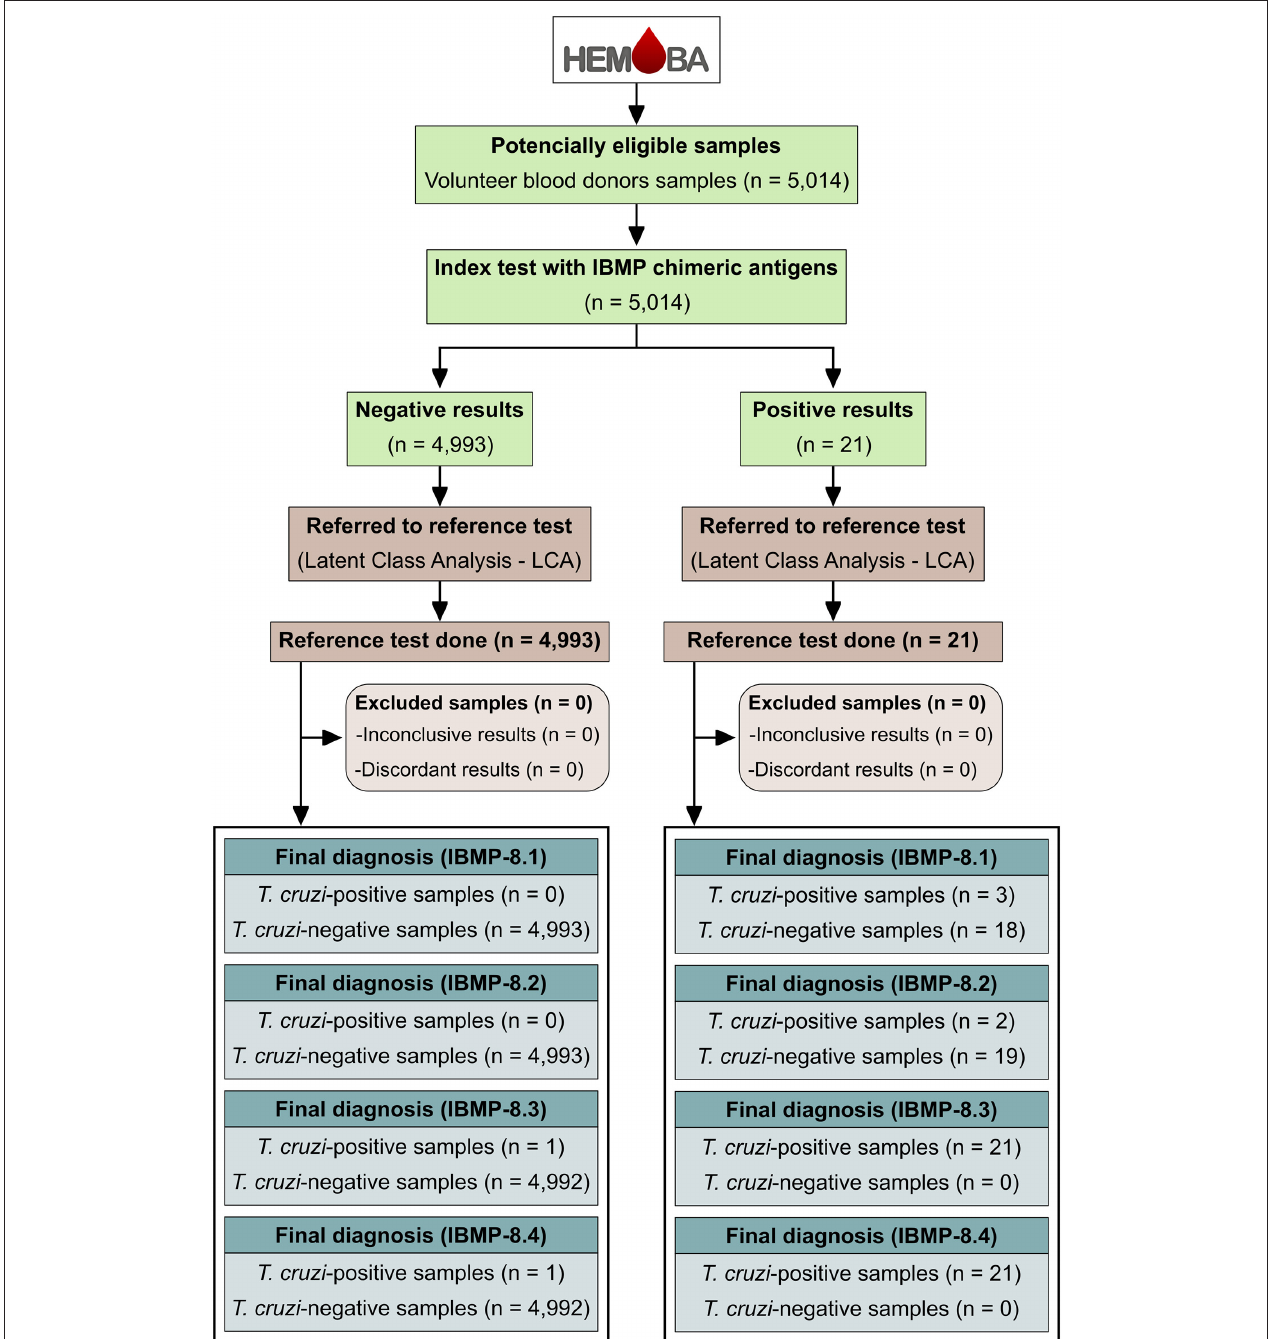
FIGURE 2 | Flowchart depicting study design in accordance with the Standards for Reporting of Diagnostic Accuracy Studies (STARD) guidelines (46).